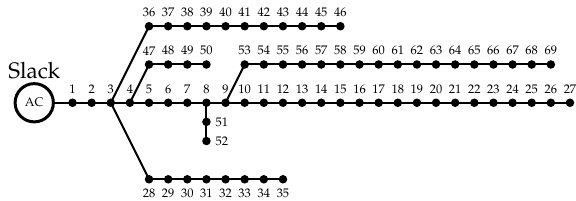
Figure 4. Electrical configuration of the 69-node radial test